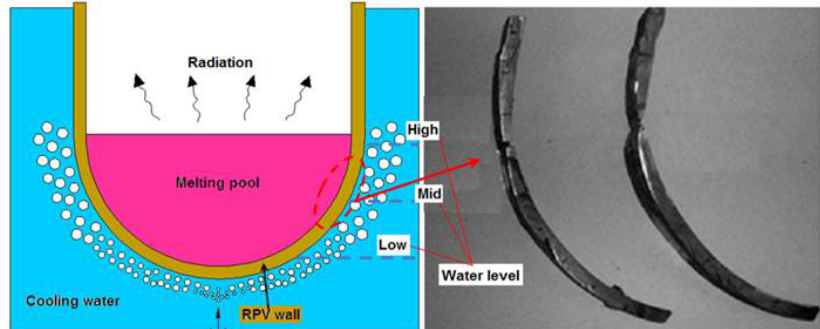
Figure 1. The scheme of RPV with water cooling in severe accident and its typical failure